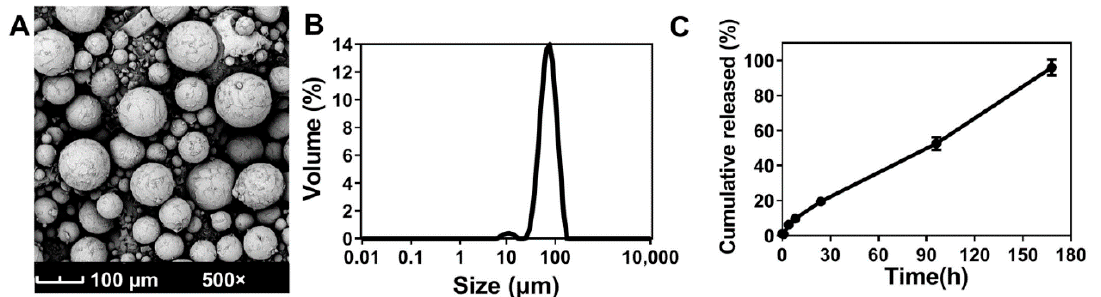
Figure 3. Characterizations of ABMs. ( A ) Image of ABMs; ( B ) Partial size distribution of ABMs; ( C ) In vitro release of ABM (Mean ± SD).